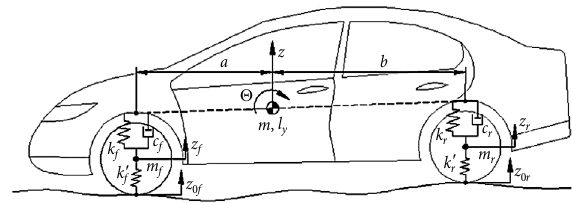
Fig. 1. Vehicle bicycle model